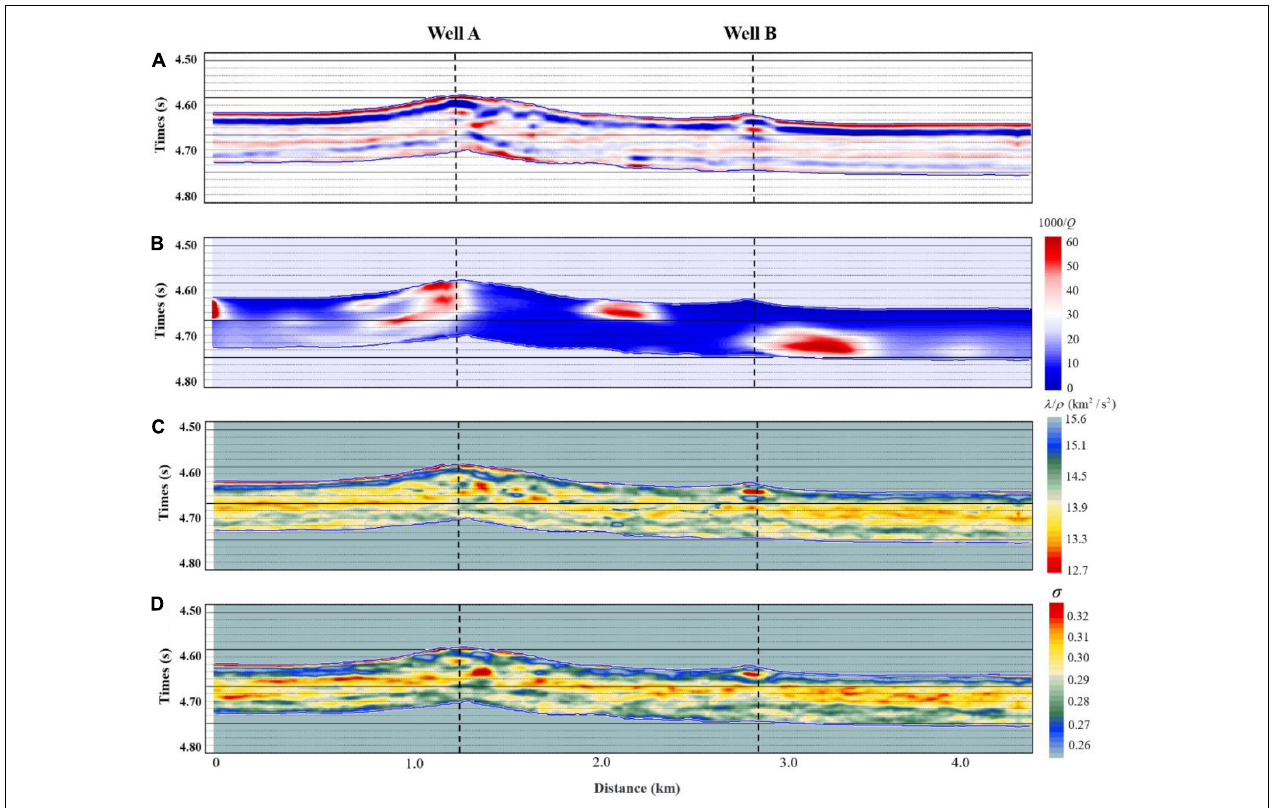
FIGURE 10 | 2D profiles of the post-stack seismic data (A) , dissipation factor (1000/ Q ) (B) , λ / ρ (C) , and Poisson’s ratio (D) of the target layer.